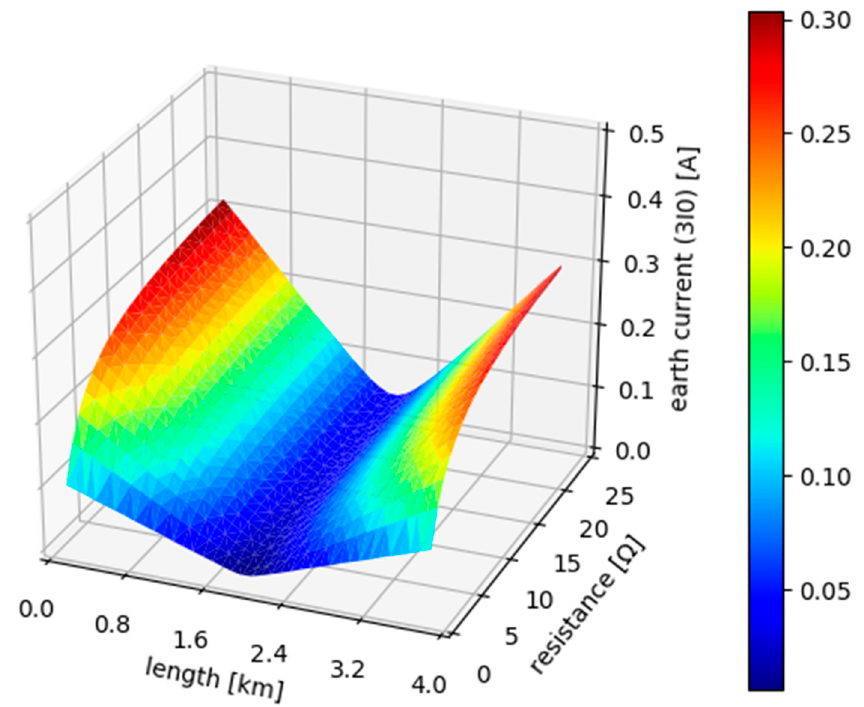
Figure 11. The earth current under no load conditions; formation presented in Figure 2c.